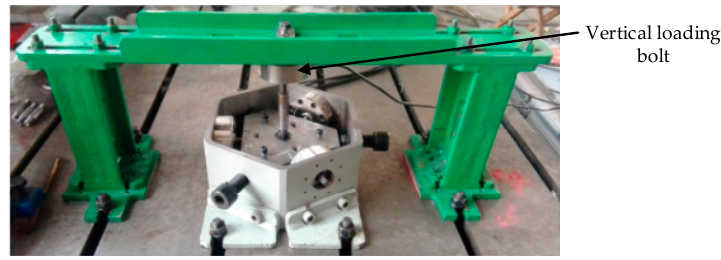
Figure 21. The calibration experiment of the vertical loading.